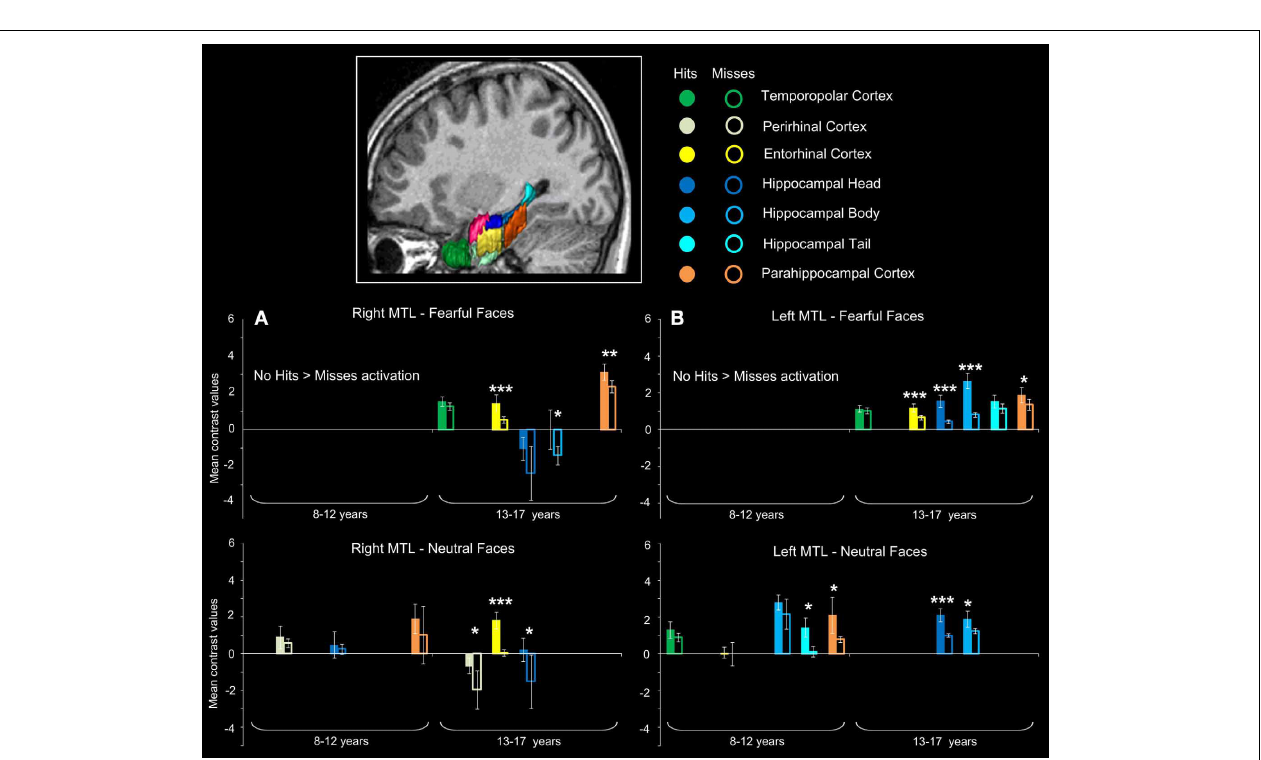
basolateral nuclei: − 24, 0, − 24) and (B) 8–12 > 13–17 years (left centromesial nuclei: − 18, − 3, − 18) contrasts ( p < 0 . 005, 5 contiguous voxels).